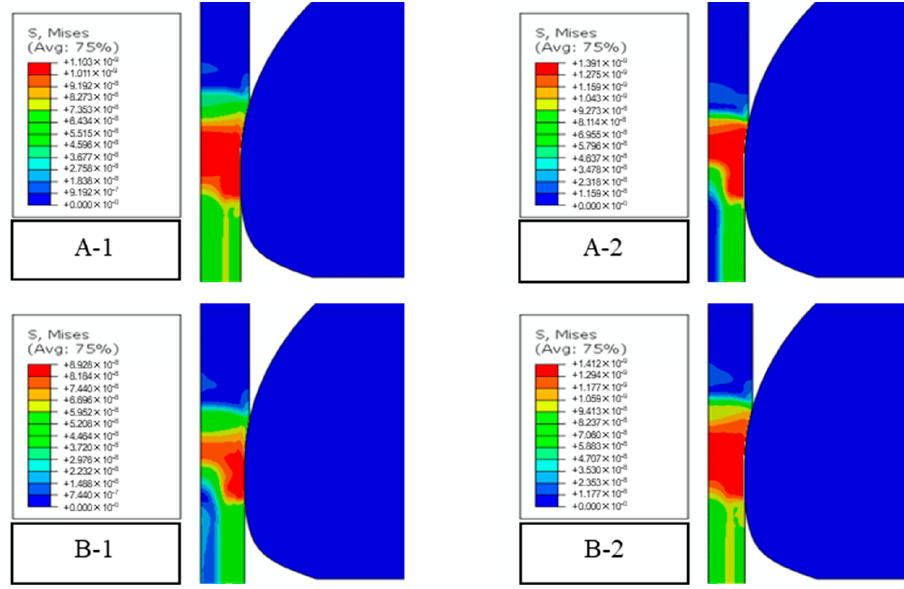
Figure 10. Axisymmetric cloud diagrams of Von Mises stress distribution in wires.